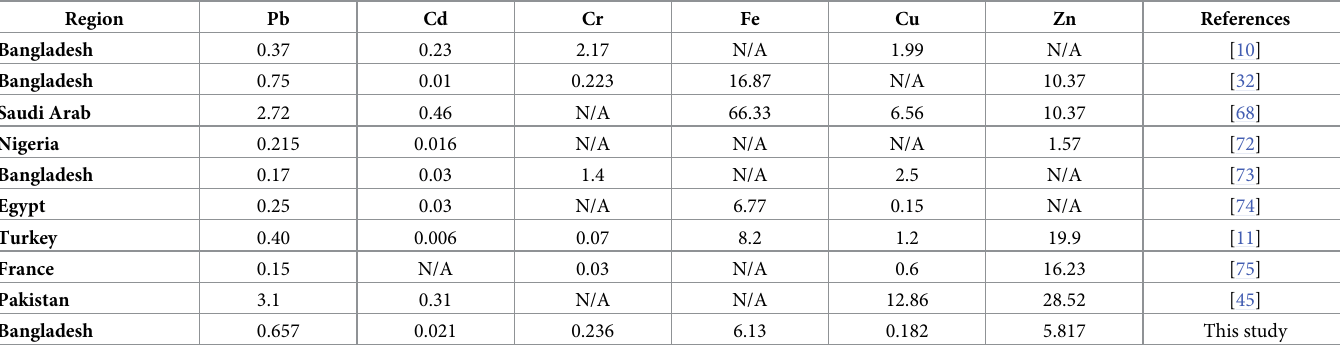
Table 4. Comparison of elemental concentrations (mg/kg FW) in chicken meat with the reported values in the literature.